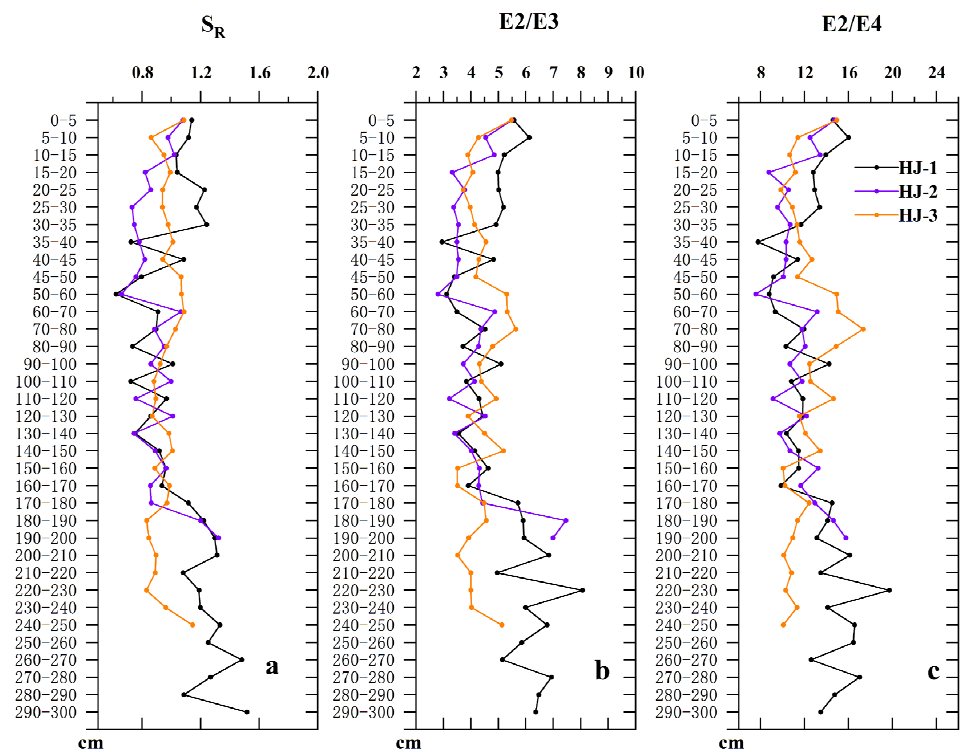
Figure 3. The content of E2/E3 ( b ), E3/E4 ( c ), and S R ( a ) in each layer of fissure soil.